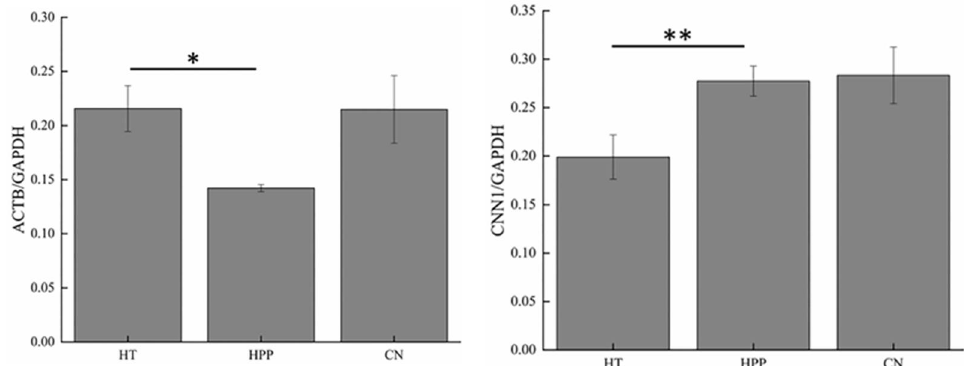
Figure 4. Analyses of Western blot bands. The band obtained by WB was analyzed by gray value, and the result was expressed as the gray value of the target band/the gray value of the reference protein. “*” stands for significant difference p < 0.05; “**” stands for significant difference p < 0.01.